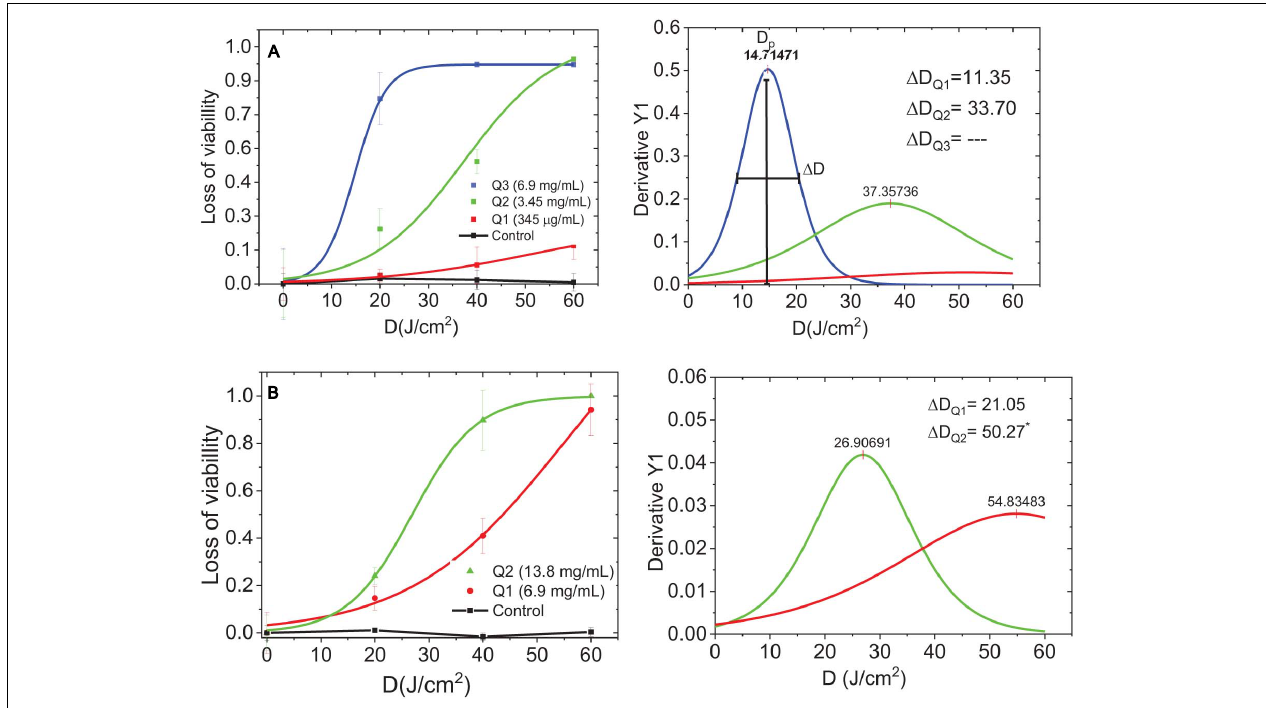
FIGURE 7 | Dose-response curves and threshold dose distribution. (A) Planktonic S. aureus + C-DOTS. (B) Biofilm of S. aureus + C-DOTS. Dp is the maximum dose of delivery light, (cid:49) D [full-width half-maximum (FWHM)] is the threshold dose distribution curves obtained from the dose–response curves. *The FWHM value found of the complete